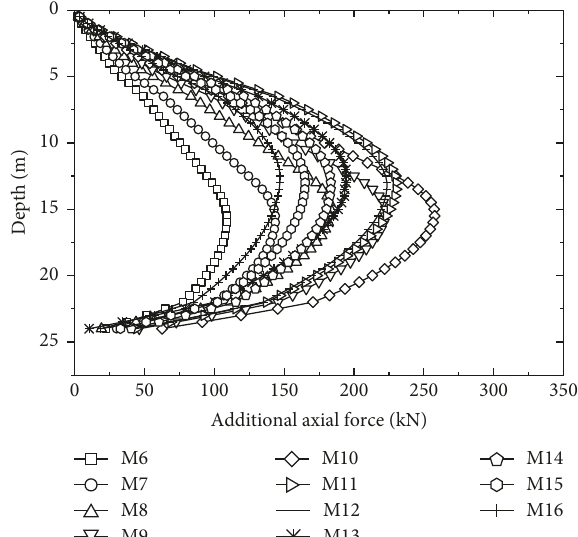
Figure 11: Additional axial force distribution of loaded pile of Fengqi road excavation.